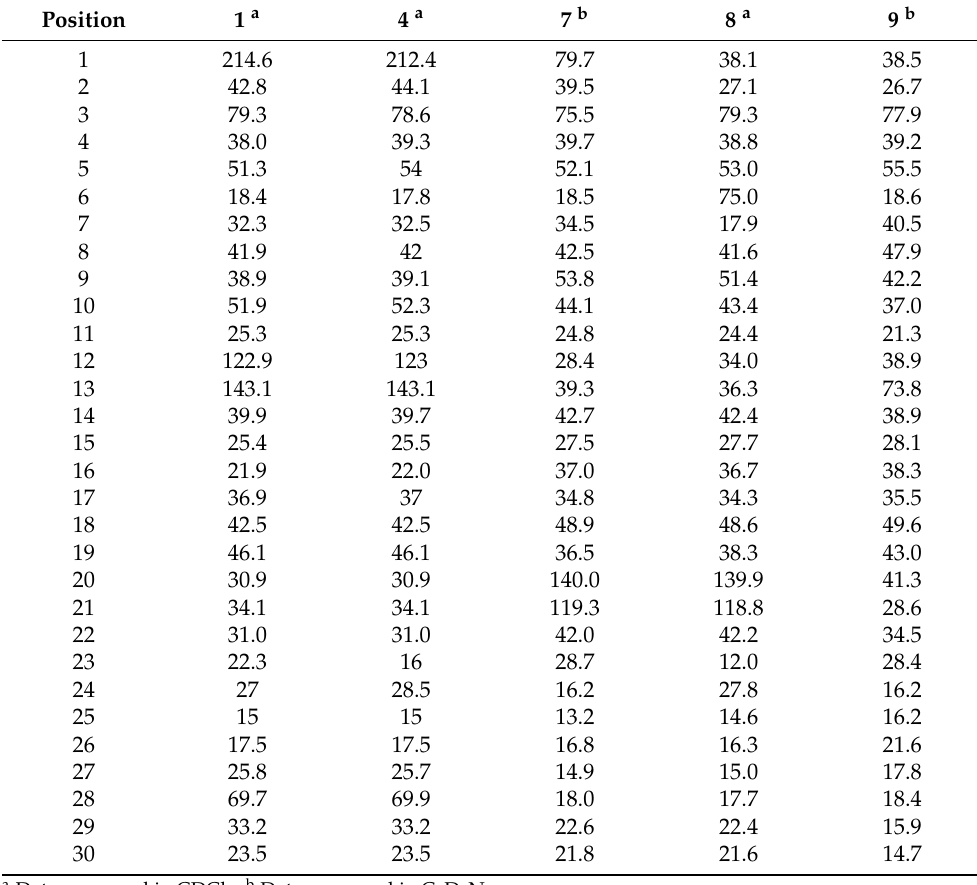
Table 2. 13 C NMR (150 MHz) data for 1, 4 , 7 , 8 , and 9 ( δ in ppm).